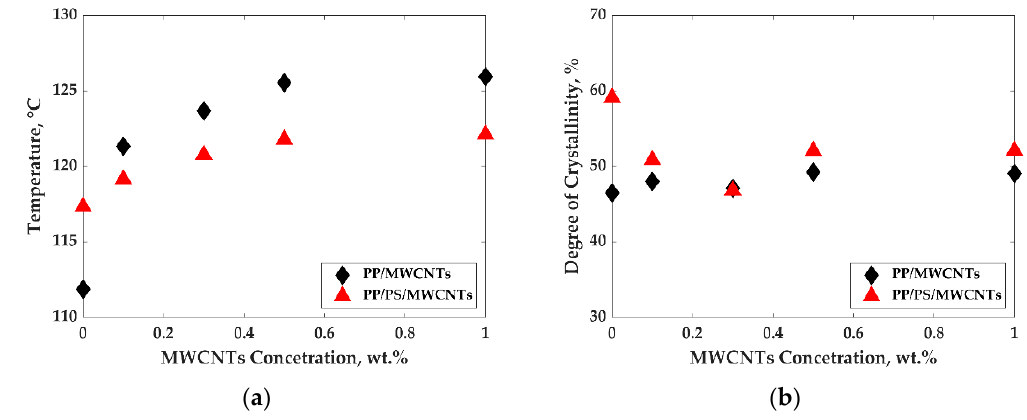
Figure 8. Effect of MWCNTs on non ‐ isothermal crystallization of PP for both PP/MWCNTs and PP/PS/MWCNTs composites: ( a ) influence of MWCNTs concentration on crystallization temperature (peak); and ( b ) the effect of MWCNTs amount on degree of crystallinity during non ‐ isothermal cooling from 200 °C to 50 °C at 10 °C/min.